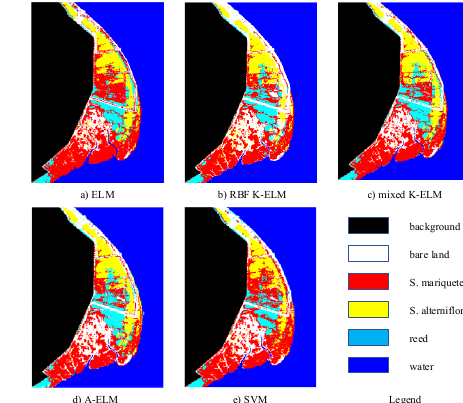
Figure 6 . Classification result of Hefei dataset.